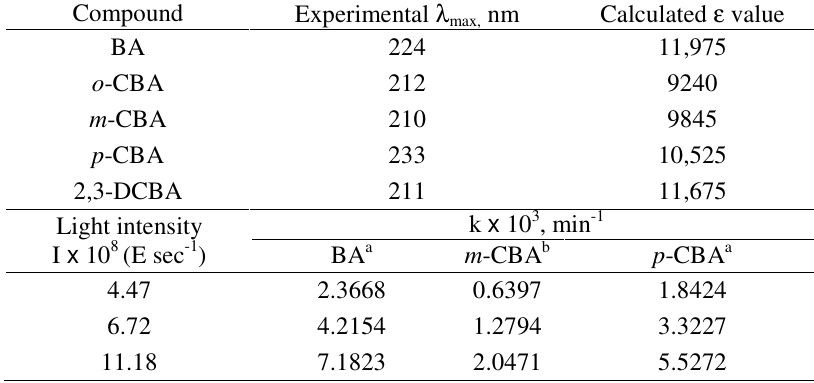
Table 1. Experimental values of molar absorptivities ( ε ) and effect of light intensity on rate of dechlorination and decarboxylation